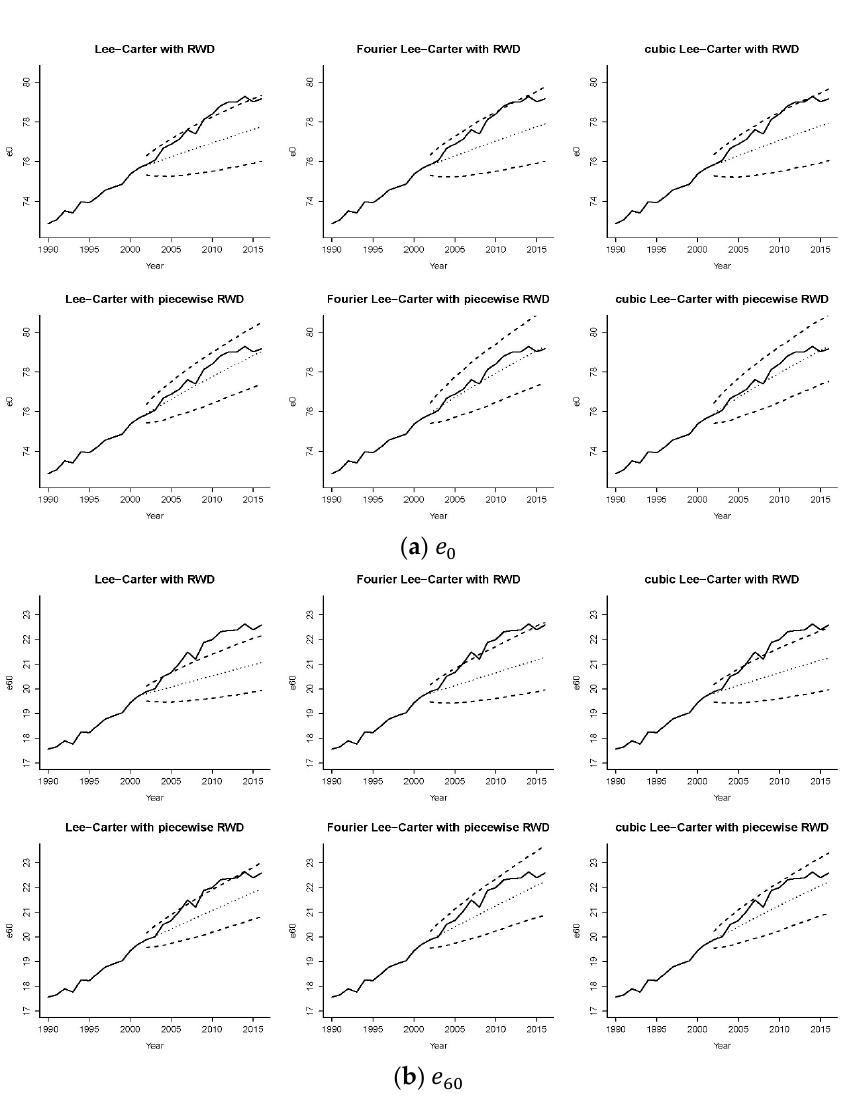
Figure 9. Observed values (solid lines), projected values (dotted lines), and 95% prediction intervals (dashed lines) of life expectancies at ages 0 (panel ( a )) and 60 (panel ( b )) for the United Kingdom, calibrated on years 1950–2001.